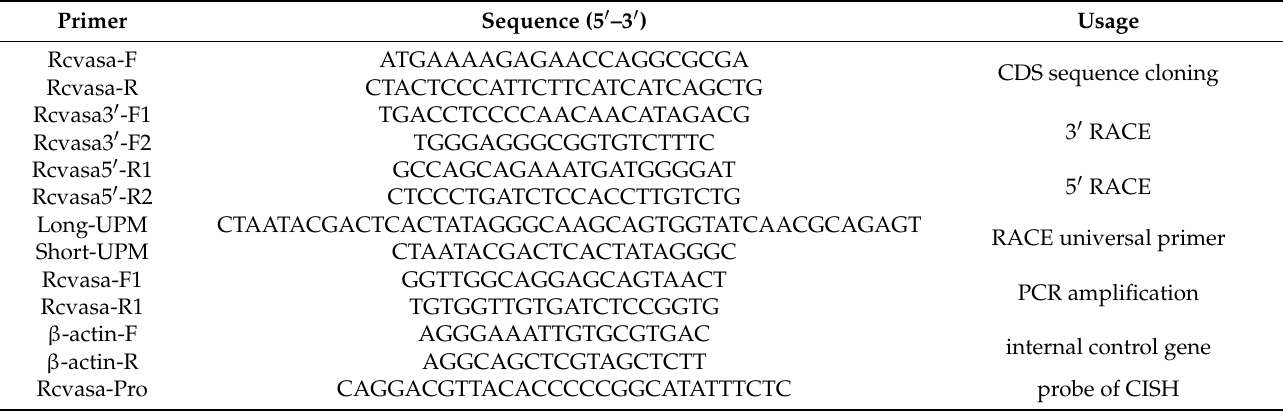
Table 1. Primer sequences used in this